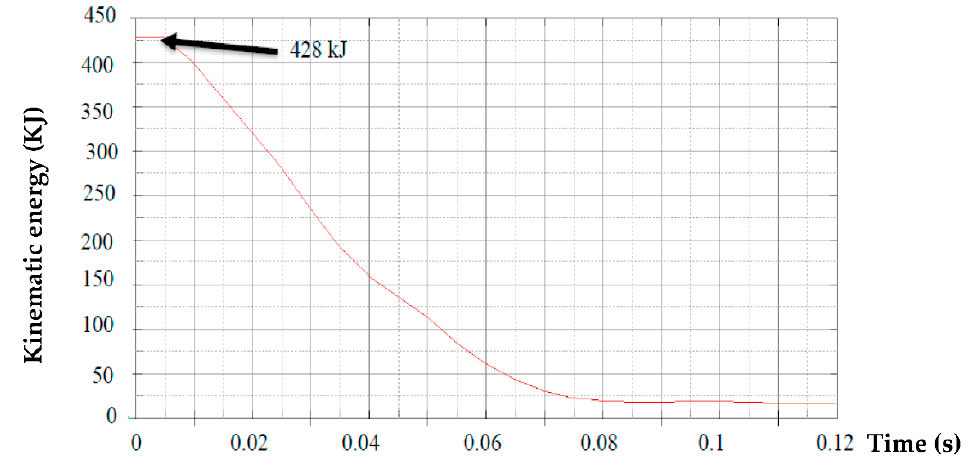
Figure 4. The kinetic energy of the armored SUV.